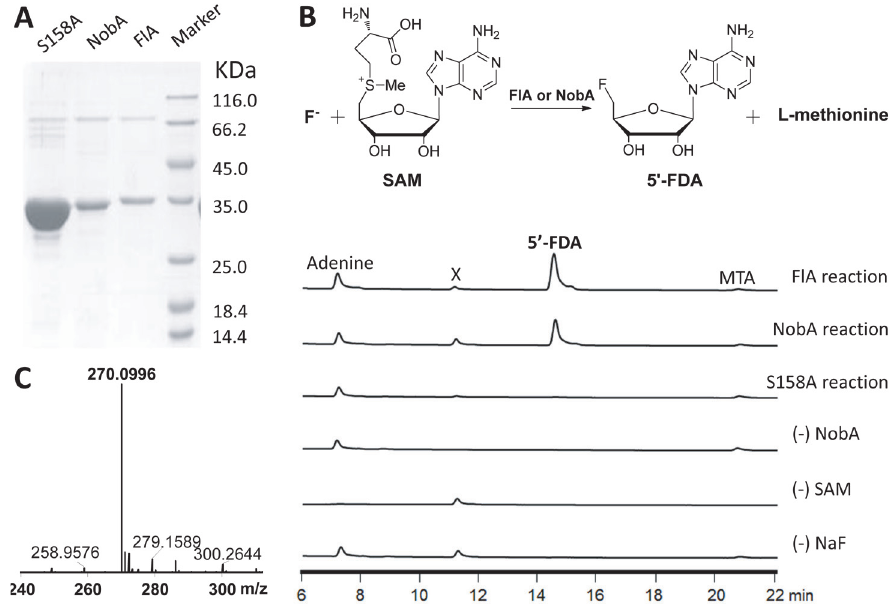
Figure 2. Fluorinase catalyzed conversion of fluoride and SAM to 5 ′ -FDA and l -methionine. A ) SDS-PAGE analysis of purified recombinant proteins. The expected sizes of NobA-S158A (34.7 kDa), NobA (34.7 kDa) and FlA (34.6 kDa) are indicated. Lane M, protein molecular weight standards. B ) HPLC showing NobA-catalyzed production of 5 ′ -FDA with various control reactions. Adenine and MTA ( S -methyl-5 ′ -thioadenosine) are from the degradation of SAM, and X is an impurity associated with NobA. C ) HRMS confirming the identity of 5 ′ -FDA. The observed value (m/z [M+H] + 270.1002) is consistent with the calculated value (m/z [M+H] +